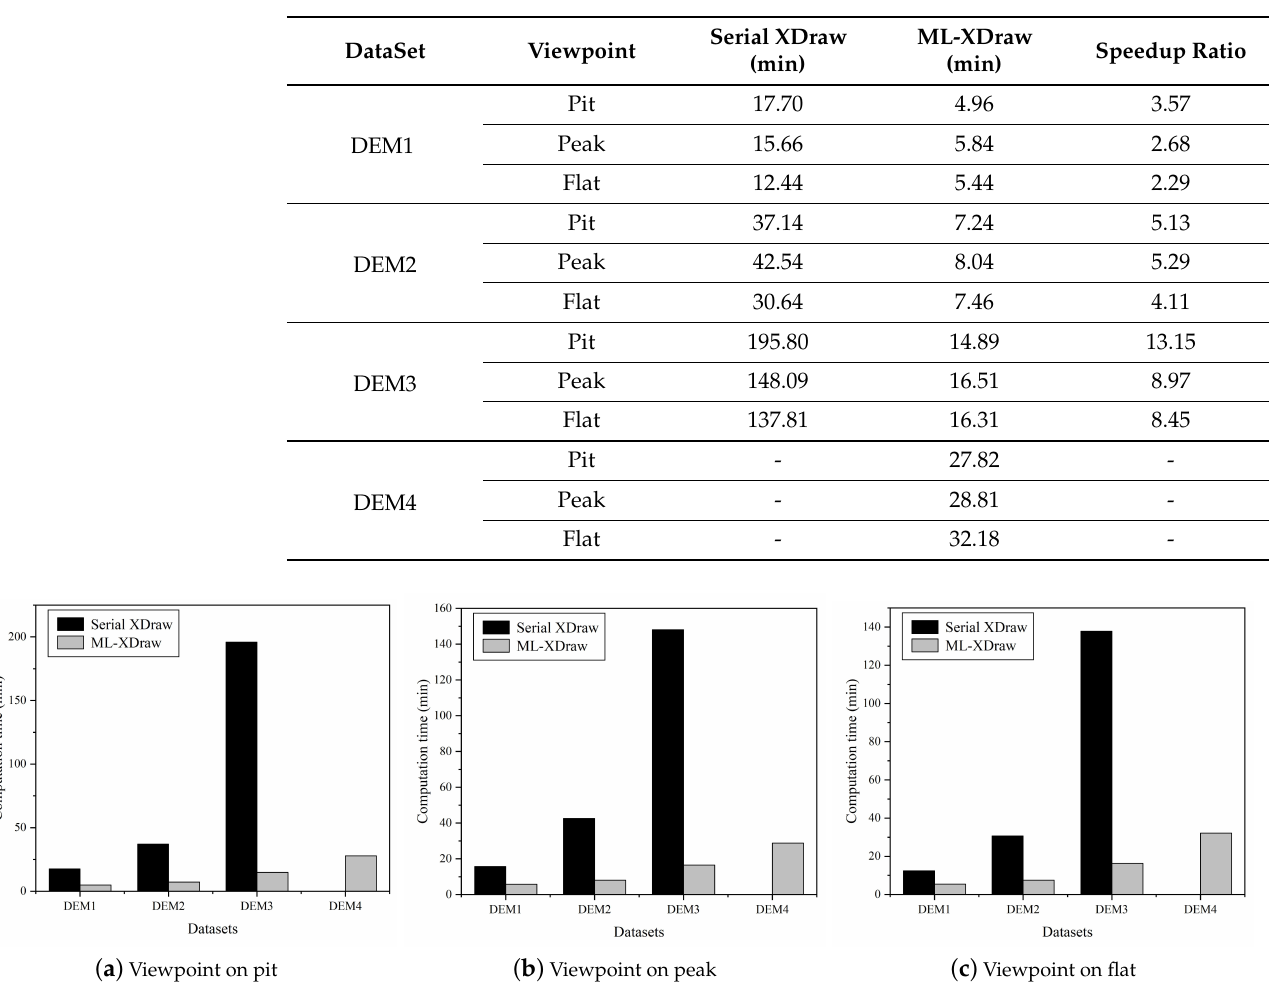
Table 3. The two algorithms’ overall computing time and speedup ratios.